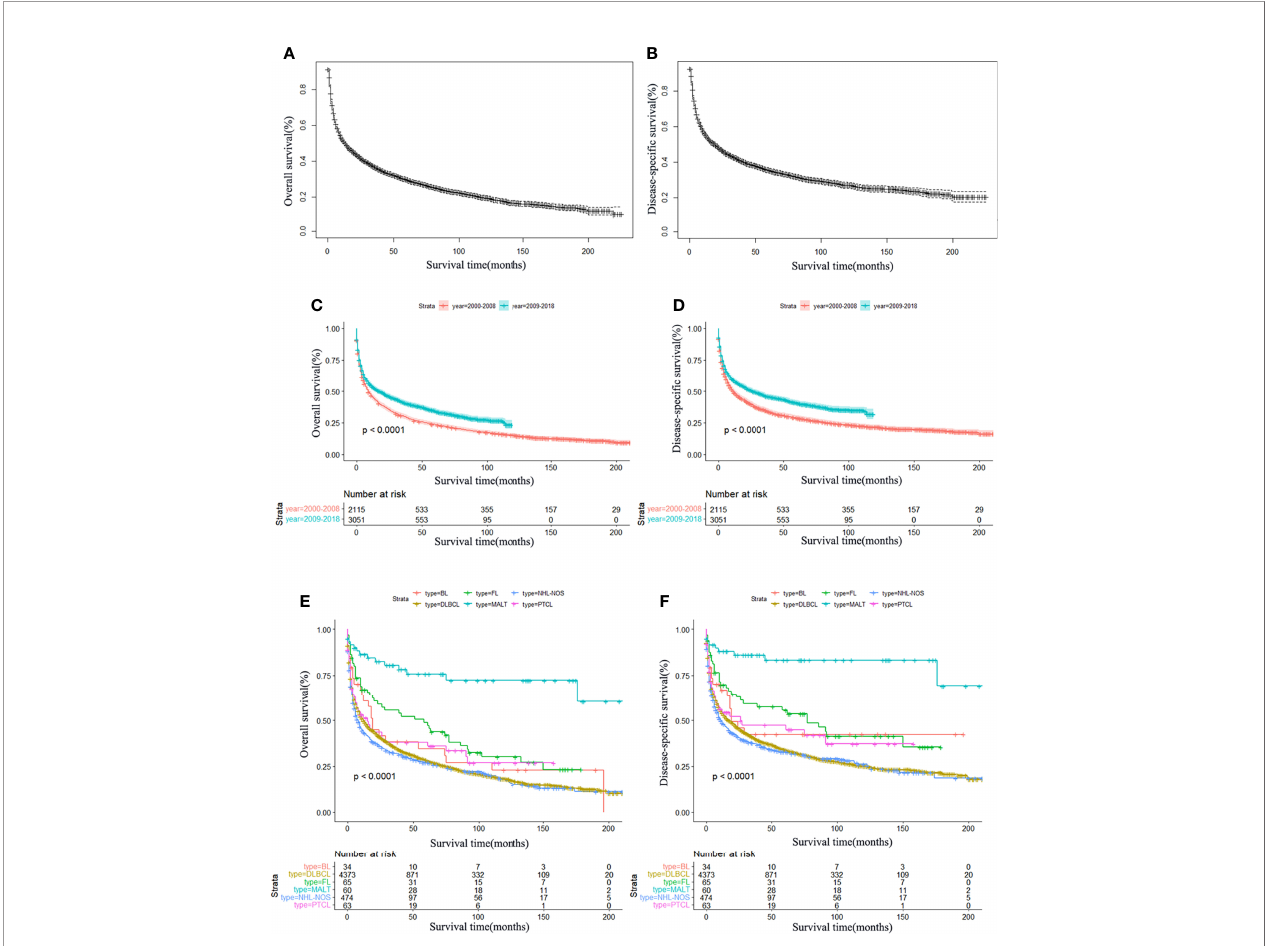
FIGURE 1 | Survival analysis of primary central nervous system lymphoma. OS (A) and DSS (B) curves for all patients. Survival analysis according to the year of diagnosis; OS (C) and DSS (D) have signi fi cantly improved in the past decades, P < 0.0001. Survival curves of OS (E) and DSS (F) according to the main histological subtypes. MALT, mucosal-associated lymphoid tissue; DLBCL, diffuse large B-cell lymphoma; BL, Burkitt ’ s lymphoma; FL, follicular lymphoma; PTCL, peripheral T-cell lymphoma; NHL, non-Hodgkin lymphoma; NOS, not otherwise speci fi